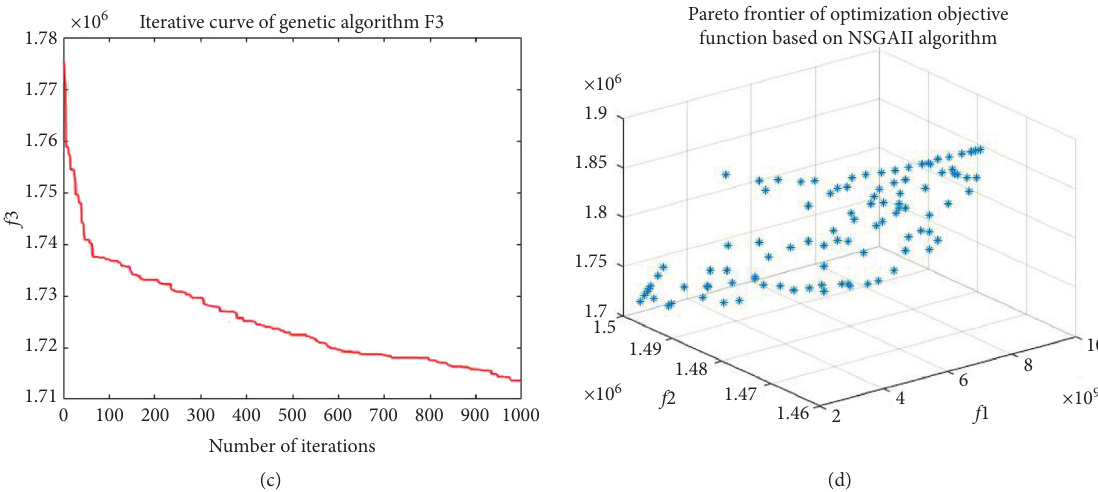
Figure 8: (a) Iterative curve of economic objectives. (b) Iterative curve of environmental objectives. (c) Iteration curve of social goals. (d) Pareto front diagram of the three objective functions.